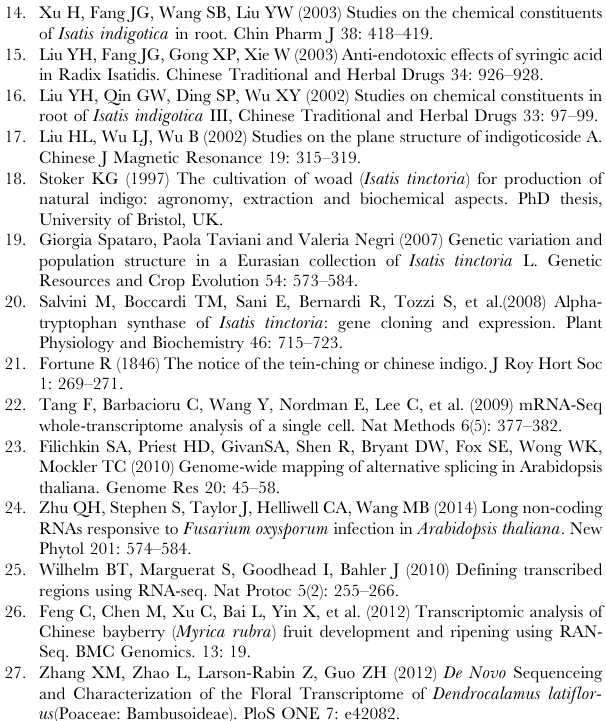
Figure S3 KEGG analysis of indole alkaloids biosynthe- sis.